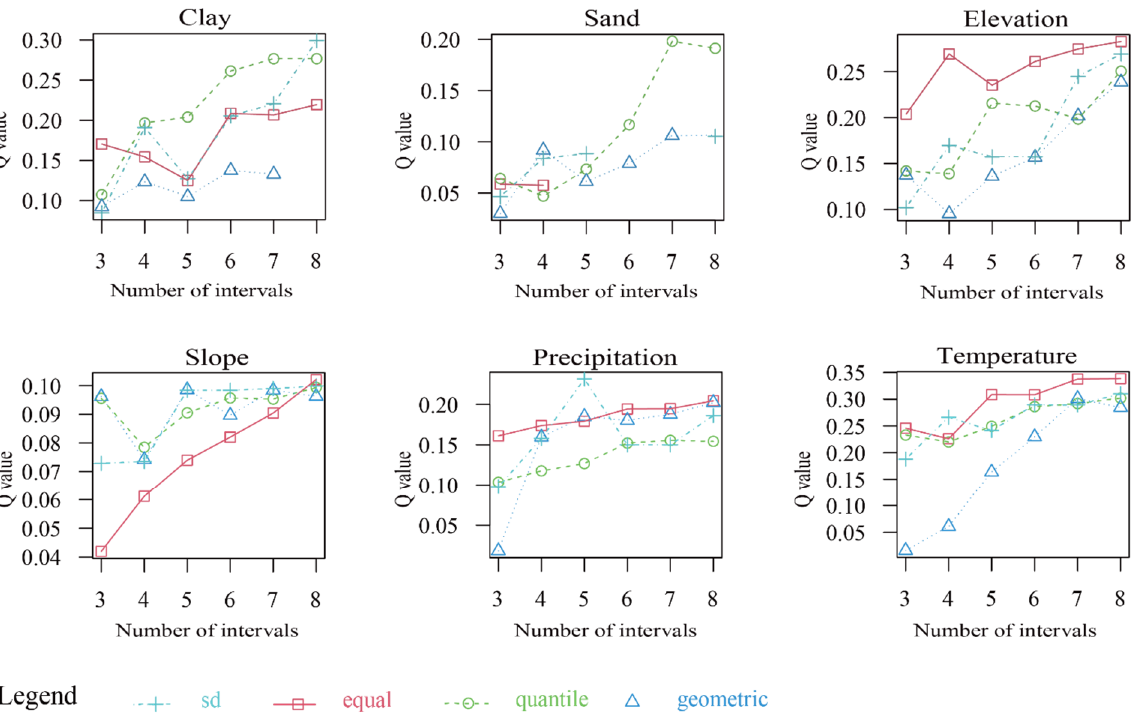
Figure 9. Parameter optimization process for the discretization of spatial data.